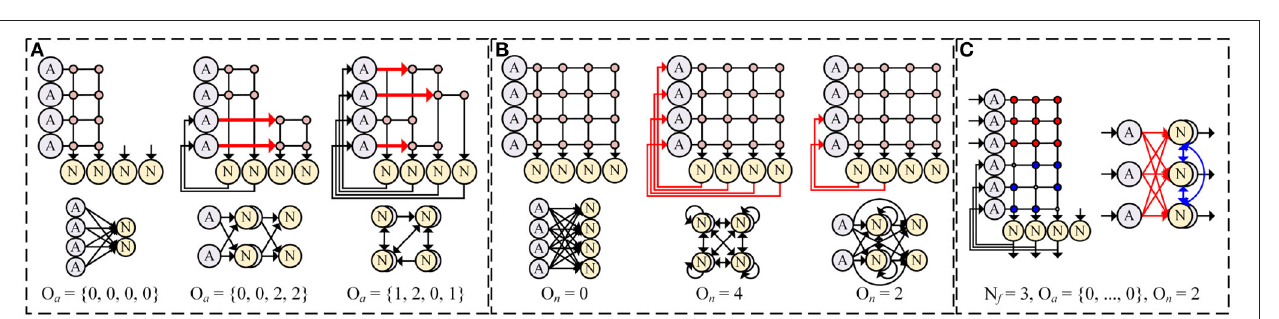
FIGURE 5 | Transposable addressing scheme ( C = 4, B = 4).